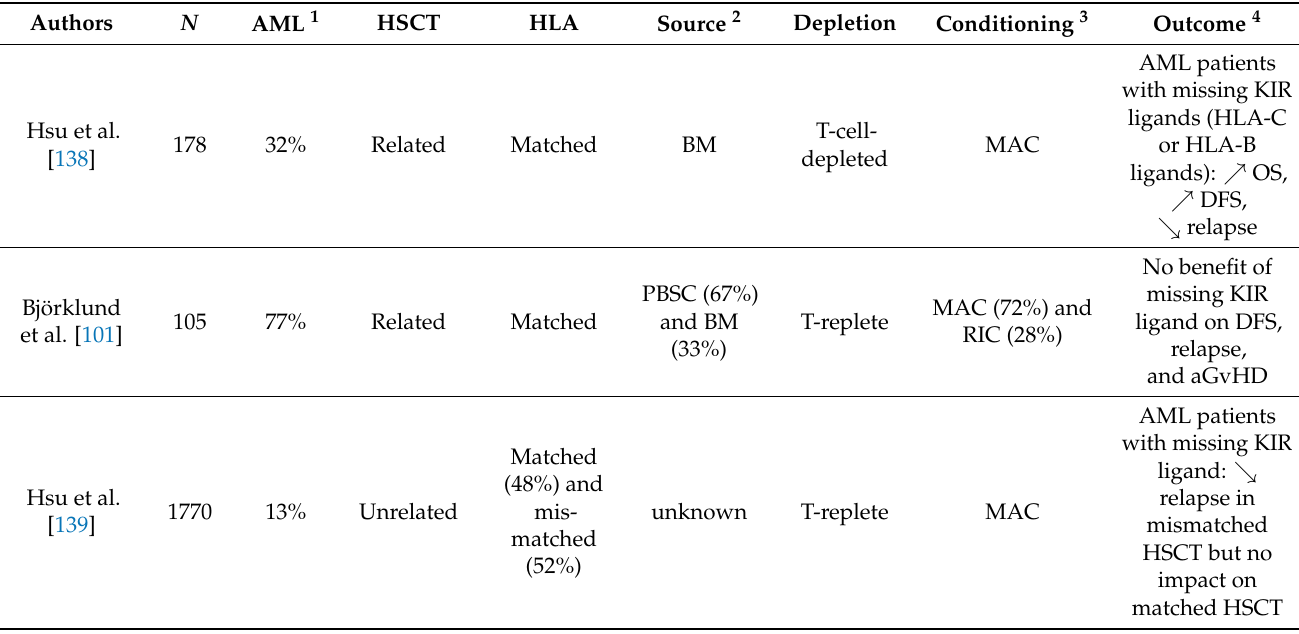
Table 1. Impacts of the genetic combinations of KIR/KIR ligands on clinical outcomes for adult AML patients, including selected studies that focused on both HLA-matched and HLA-mismatched